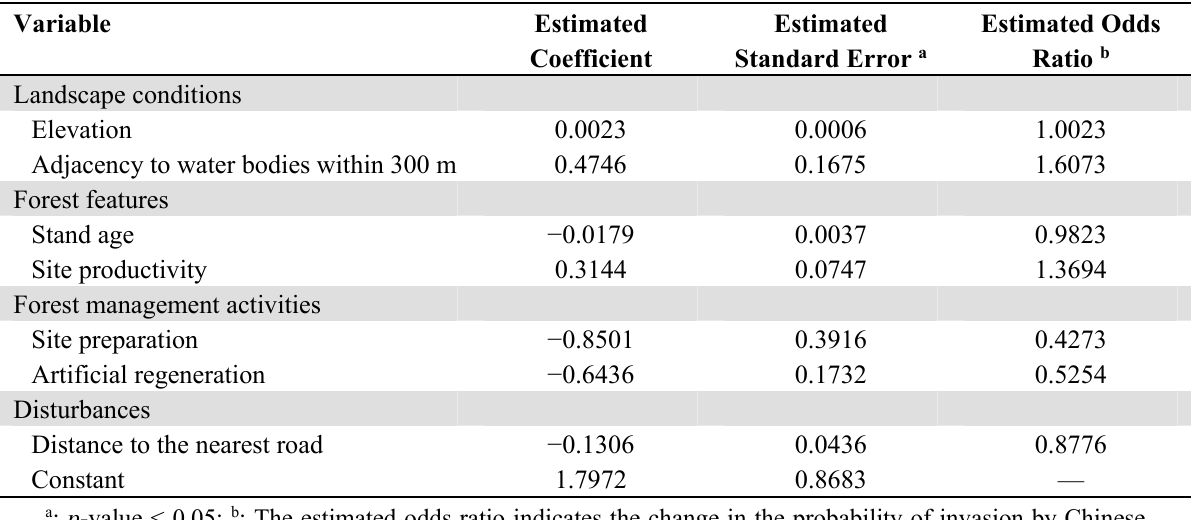
Table 2. Potential determinants of Chinese privet invasions of forested plots in Eastern Texas as indicated by results of stepwise multiple logistic